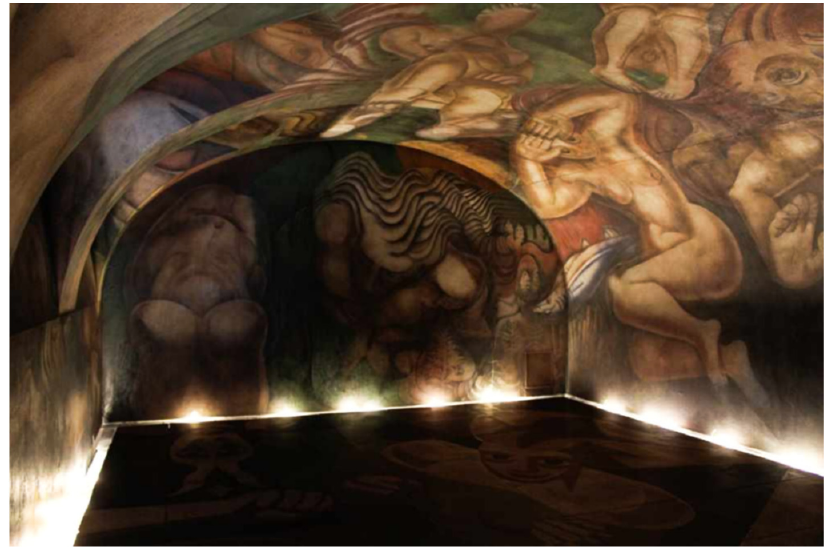
Figure 2. David Alfaro Siqueiros Ejercicio Plástico (Plastic Exercise), 1933. Restored in 2009 and installed at Casa Rosada Museum, Buenos Aires. Photograph courtesy of Walter Raymond. © DACS 2021.